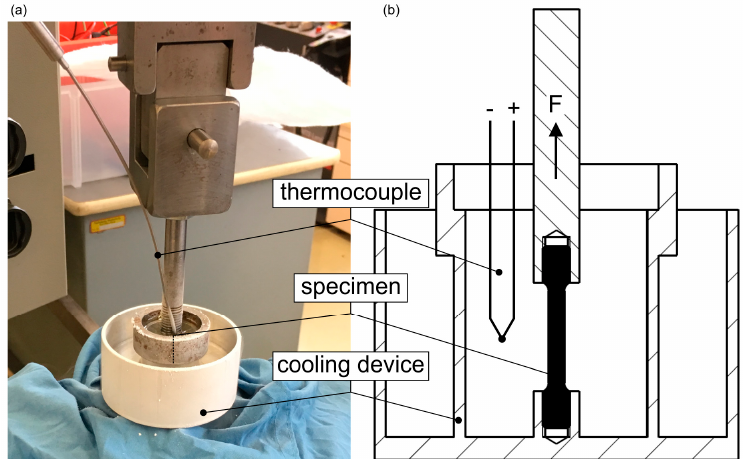
Figure 1. Experimental setup applied for tensile tests at different temperatures below room temperature (RT) as ( a ) photograph, and ( b ) as schematic drawing. The setup consists of a special double–ring cooling device surrounding the tensile specimen. The testing temperature is measured with a thermocouple placed on the sample